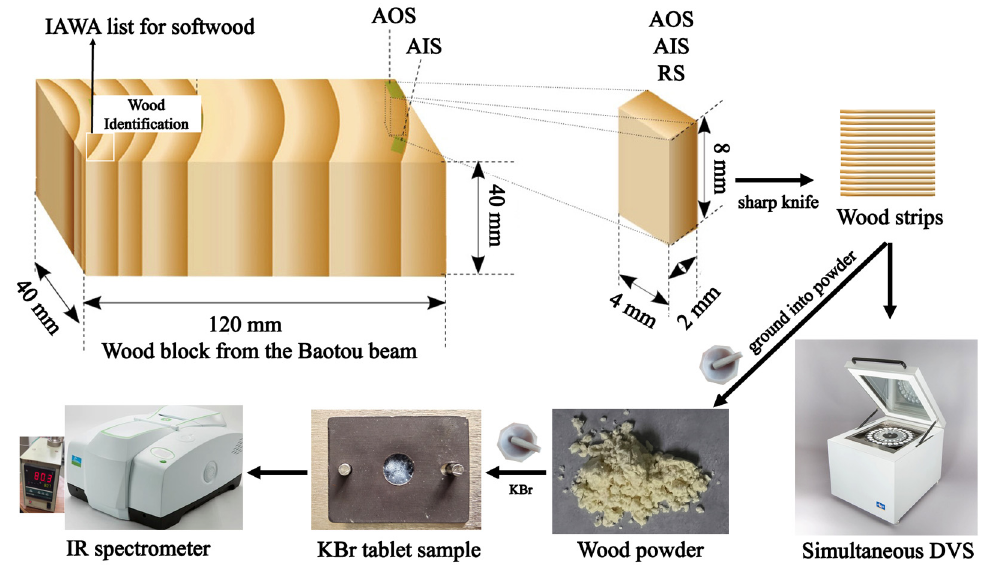
Figure 8. Schematic of sample preparation and measurements.